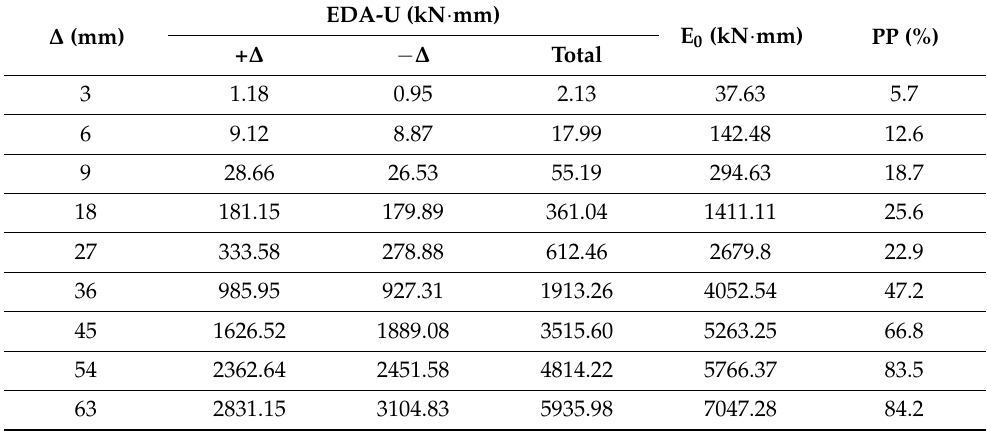
Table 3. Energy dissipation capacities of the steel